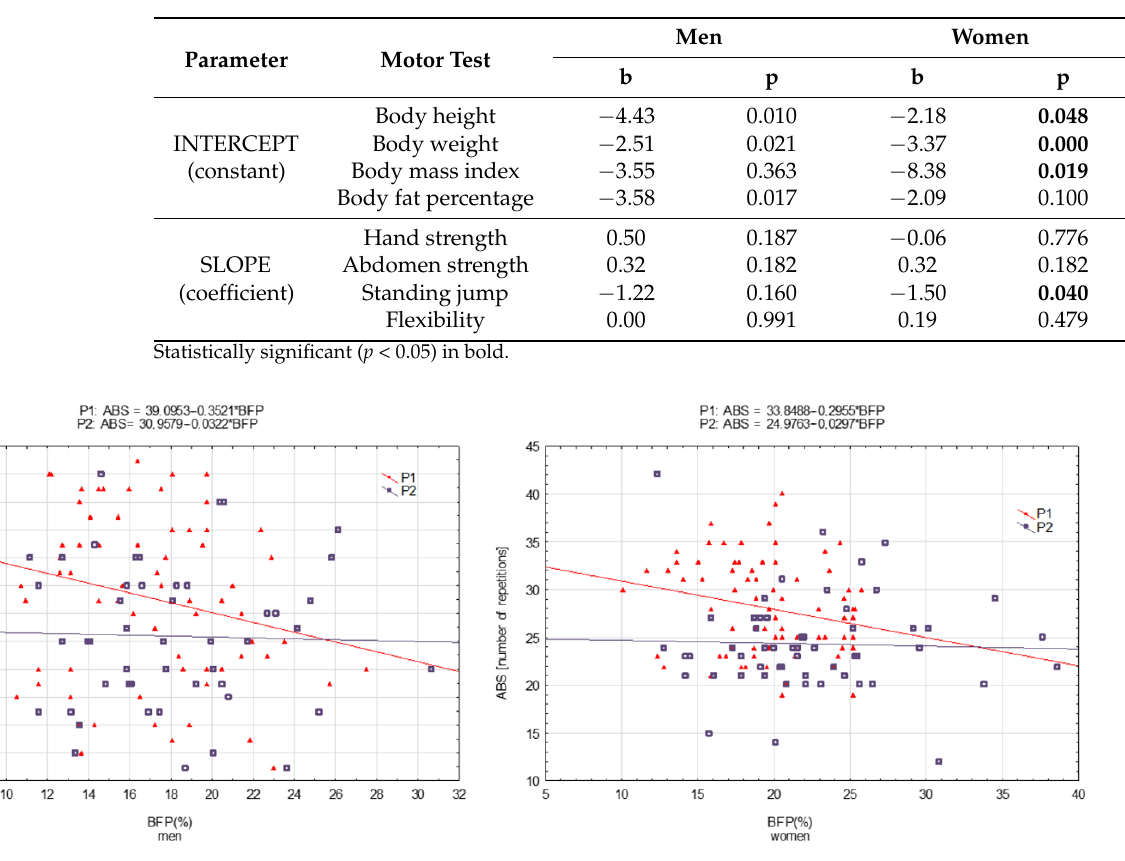
Figure 2. Abdomen strength (ABS) measured in 2001 (P 1 ) and 2022 (P 2 ) regressed on body fat percentage (BFP)—men and women,